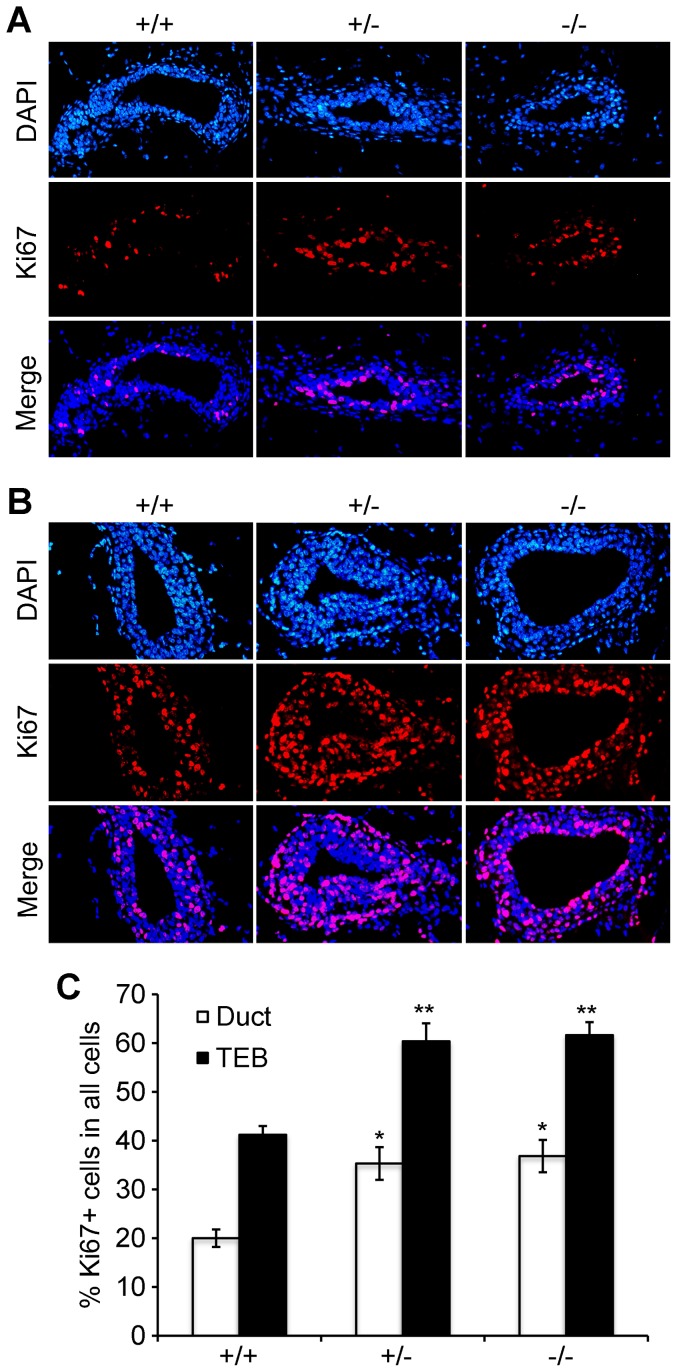
Cell proliferation activity is increased by the knockout of Atbf1 in mammary epithelial cells from 6-week old mice.(A–B) Tissue sections of mammary ducts (A) and terminal end buds (TEBs) (B) were subjected to IF staining against Ki67. DAPI staining was used to show nuclei (blue) and Ki67 was labeled by RITC (red). (C) Ratios of Ki67-positive cells to total epithelial cells in mammary glands with different Atbf1 genotypes were calculated. Each bar indicates the average result from 10 randomly selected areas. Three mice were used for each genotype, and the number of mammary epithelial cells counted for each bar was 1200–1600 for ducts and 2000–2800 for TEBs. *, P<0.05 and **, P<0.01 (one-way ANOVA).